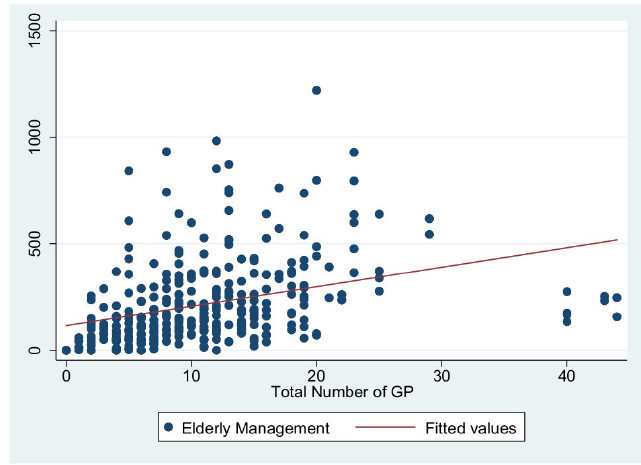
Figure 3. Scatter diagram of elderly management and total number of GPs.